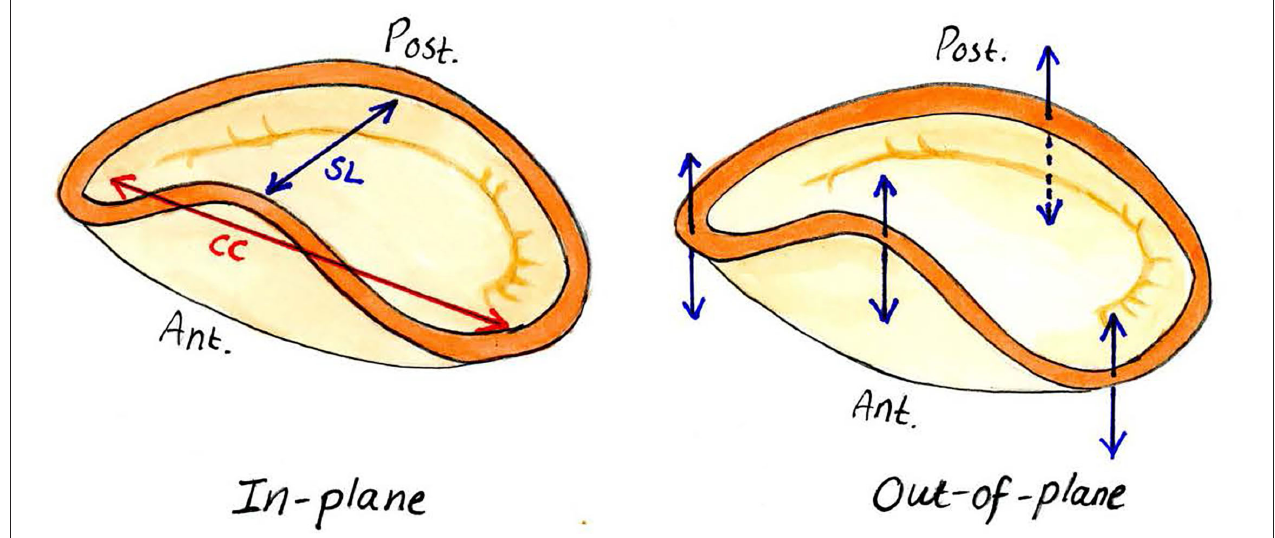
FIGURE 1 | In-plane and out-of-plane forces acting on the mitral annulus. SL, septo-lateral dimension; CC, commissural-commissural dimension. The arrows represent the in-plane and out-of-plane forces, respectively.